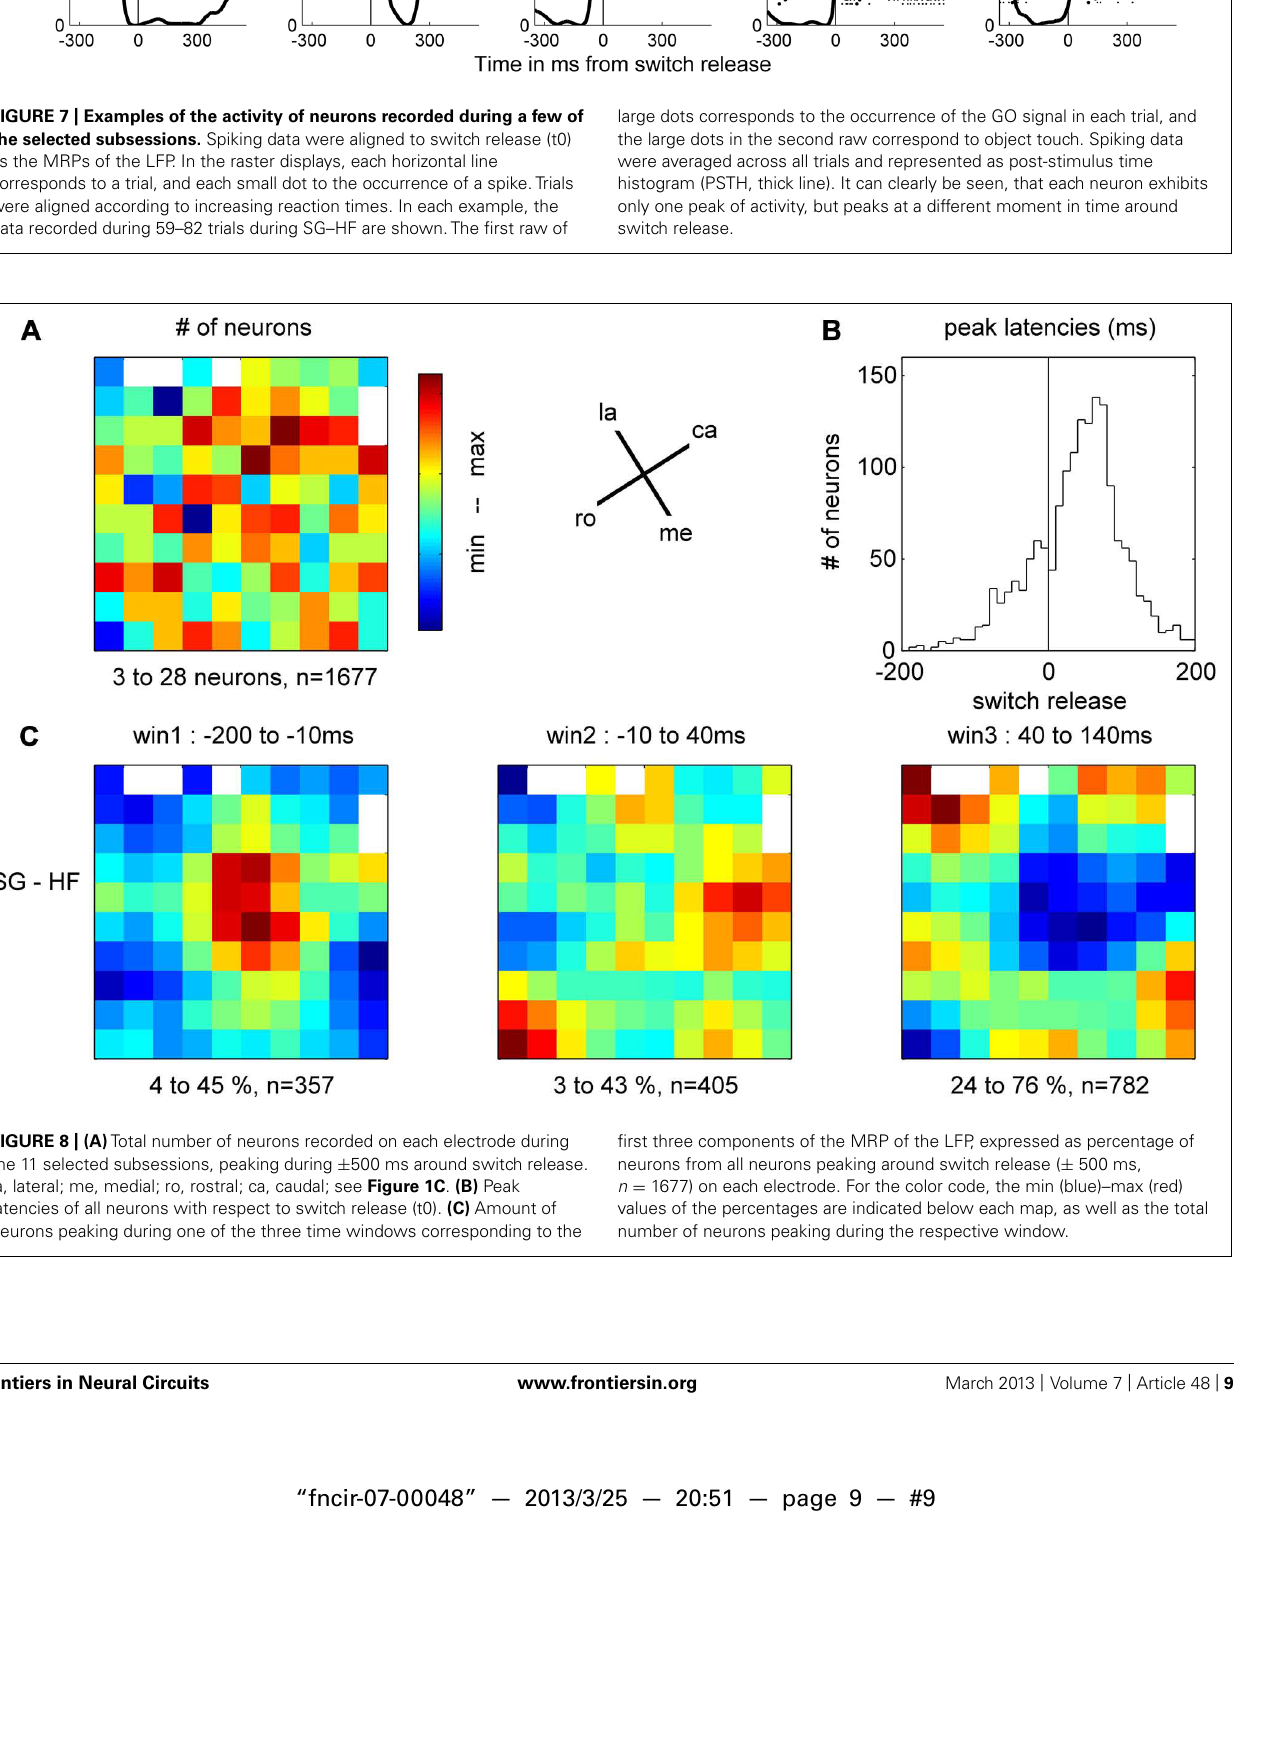
large dots corresponds to the occurrence of the GO signal in each trial, and the large dots in the second raw correspond to object touch. Spiking data were averaged across all trials and represented as post-stimulus time histogram (PSTH, thick line). It can clearly be seen, that each neuron exhibits only one peak of activity, but peaks at a different moment in time around switch release.